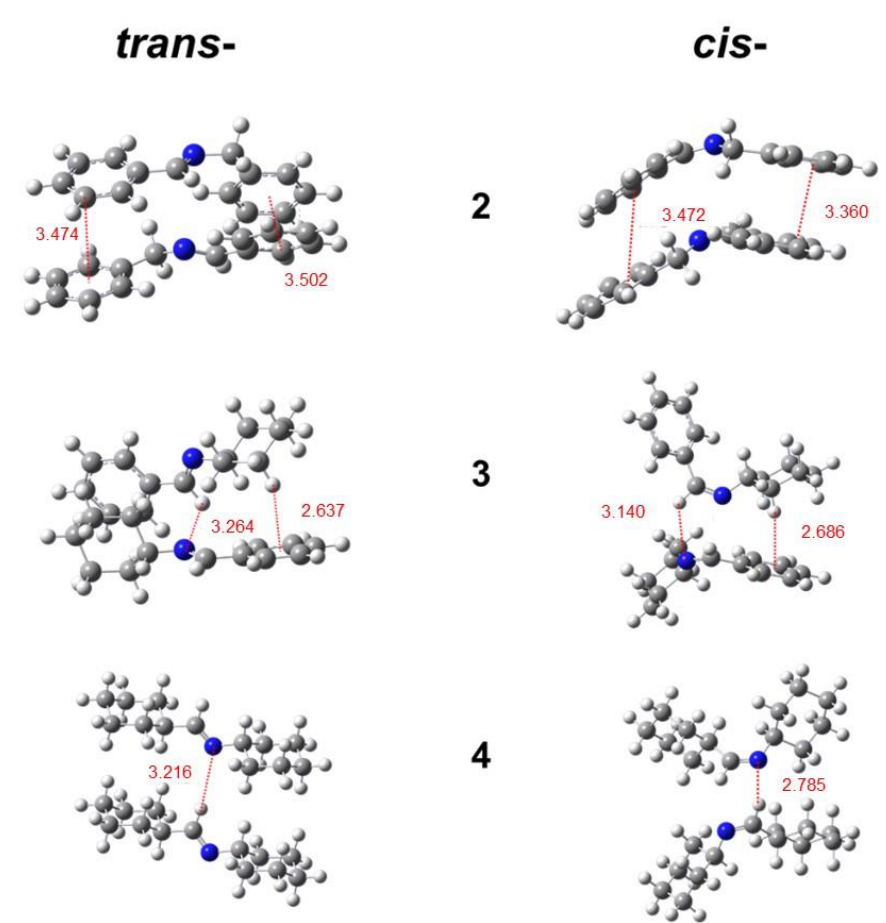
Figure 6. Optimized conformations of the dimers of imines 2 , 3 , and 4 in trans - and cis -configurations.